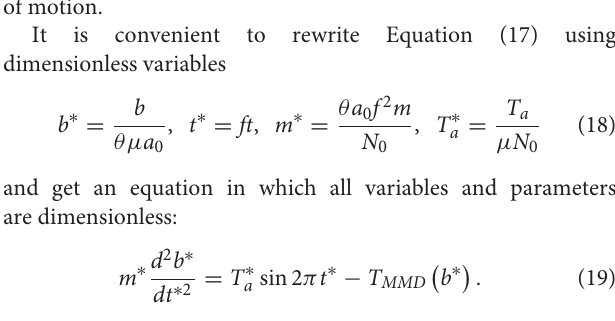
In the considered case involving inertia, it is meaningful to distinguish between excitation and loading